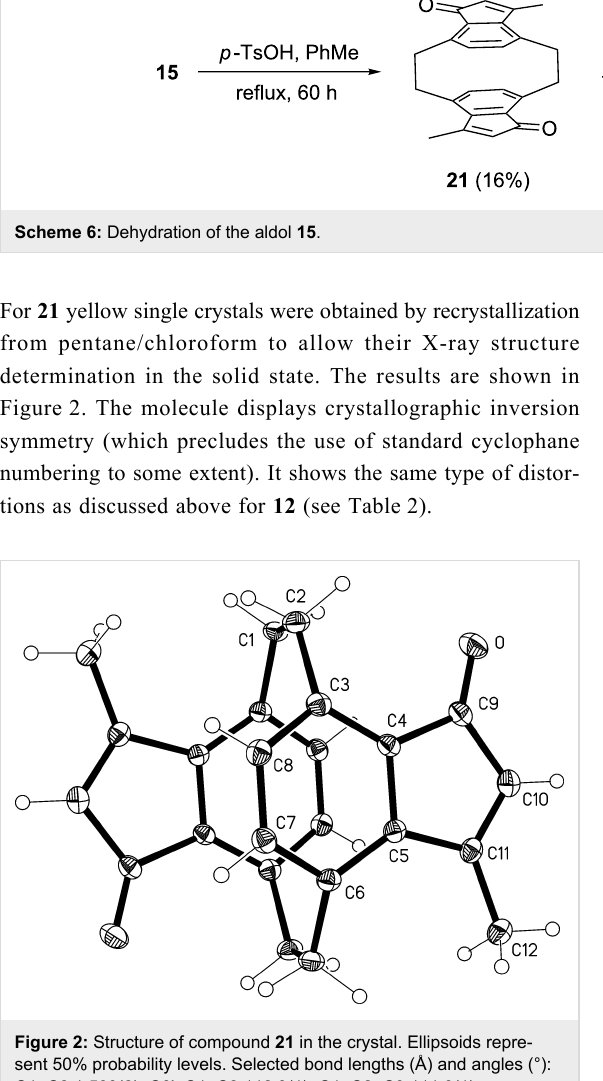
Figure 2: Structure of compound 21 in the crystal. Ellipsoids repre- sent 50% probability levels. Selected bond lengths (Å) and angles (°): C1–C2 1.589(2), C6'–C1–C2 112.9(1), C1–C2–C3 111.8(1), C4–C3–C8 115.3(1), C5–C6–C7 115.4(1).